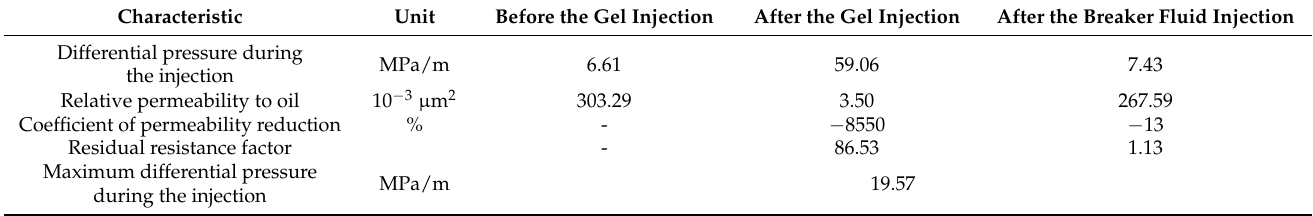
Table 3. Results of the flooding experiment on oil-saturated fractured porous core sample.